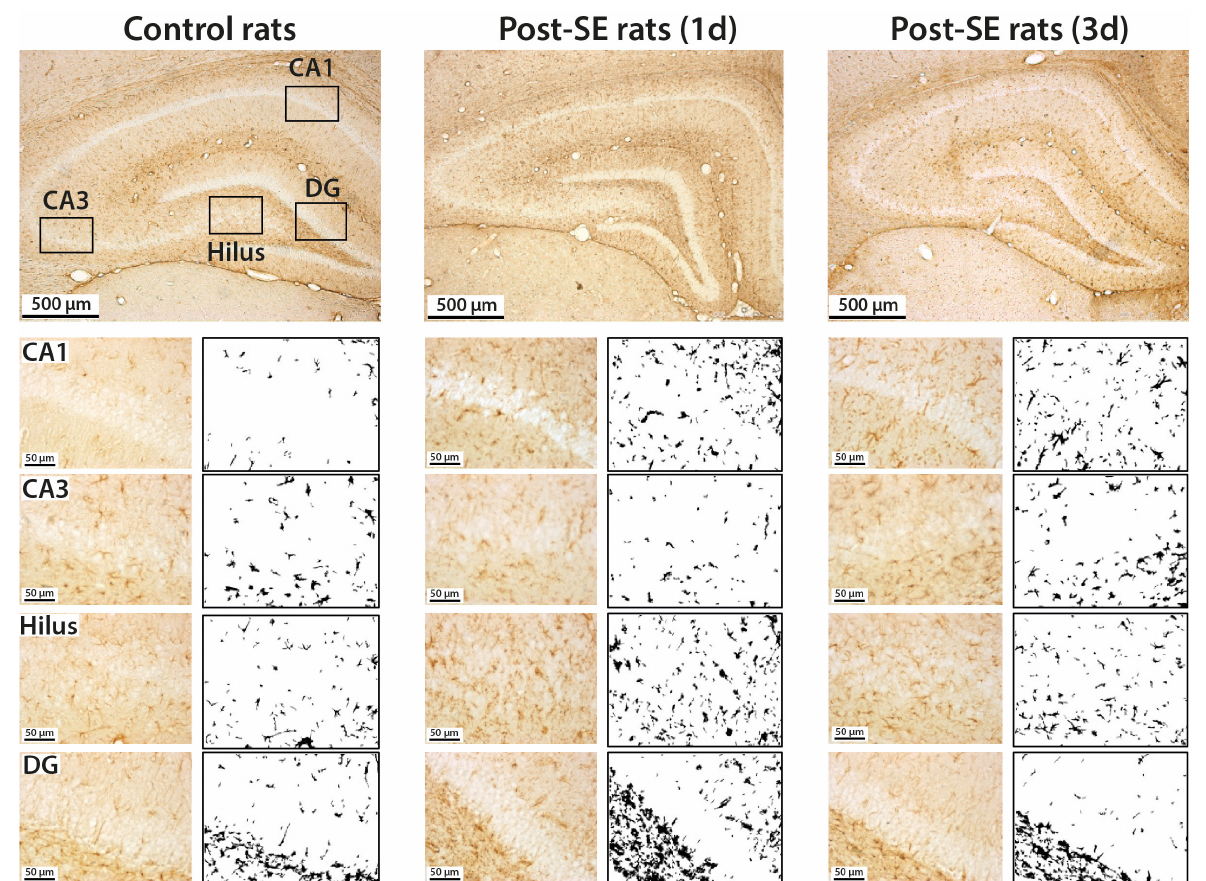
Figure A1. Astrogliosis in the rat hippocampus following pilocarpine-induced SE. Immunohistochemistry targeting glial fibrillary acidic protein (GFAP) was used for the detection of astrocytes. Representative images of hippocampal sections with GFAP-positive cells and their corresponding black–white masks were obtained with ImageJ software and used for area counting (upper panels: × 5 magnification and lower panels: × 40 magnification).